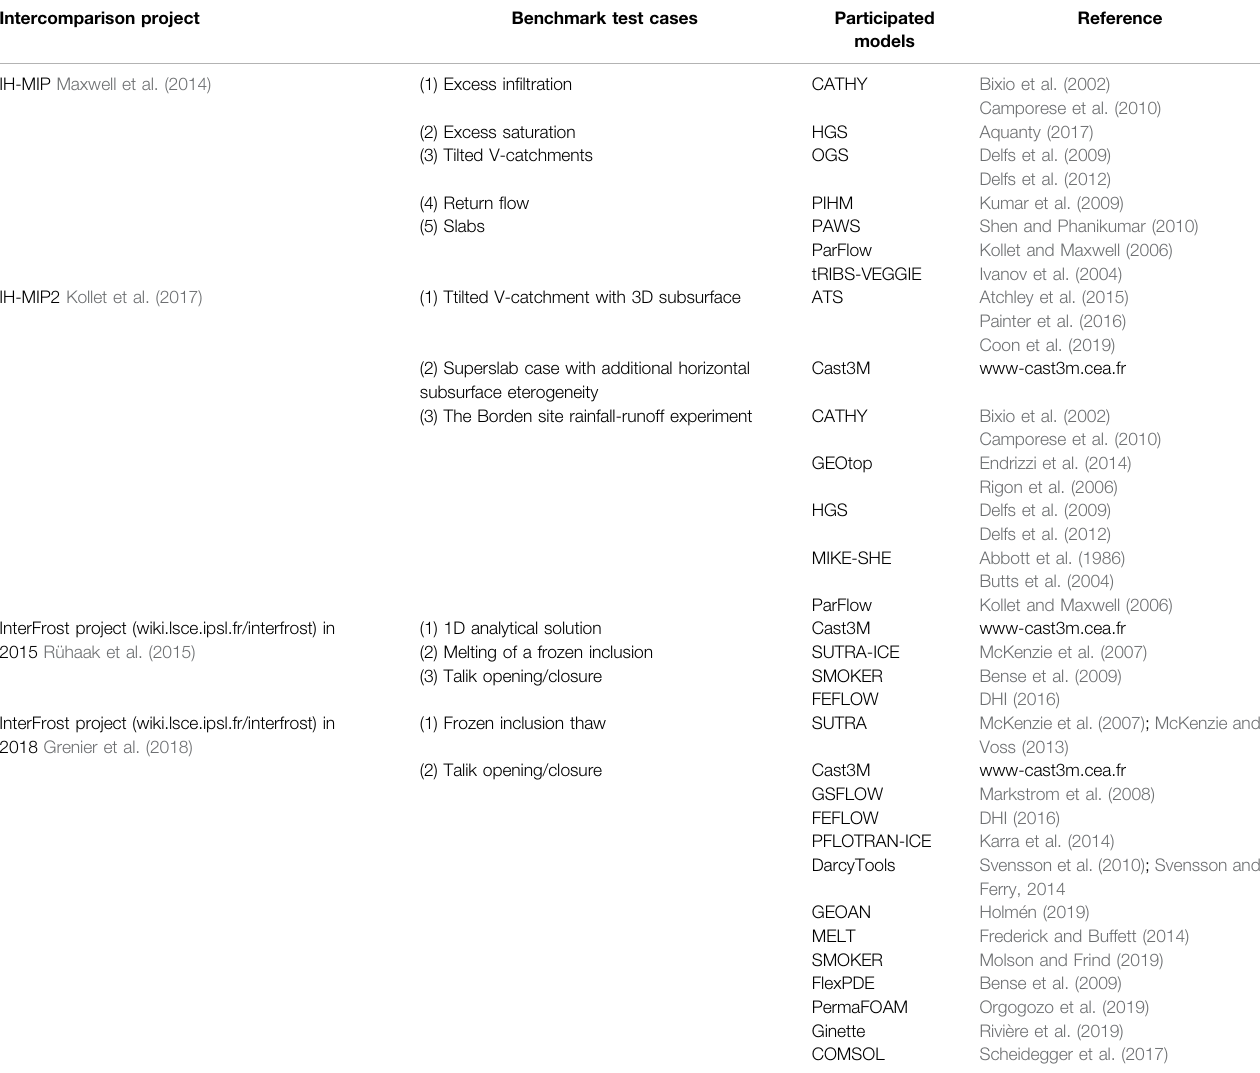
TABLE 2 | Summary of the model benchmarking